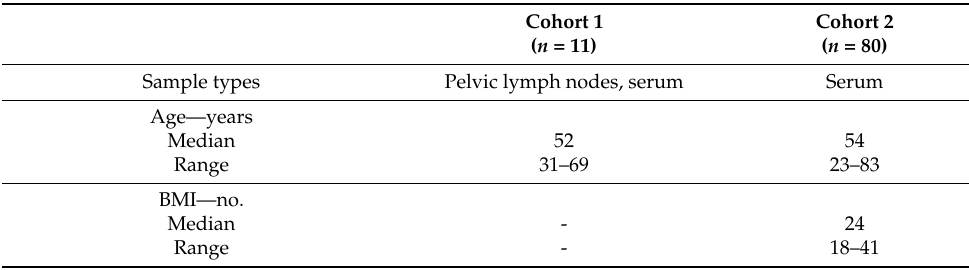
Table 4. Summary of ovarian cancer patient characteristics across both cohorts. This includes sample number, age, body mass index (BMI), ethnicity, risk factors, disease stage, subtype and cancer antigen-125 (CA-125)